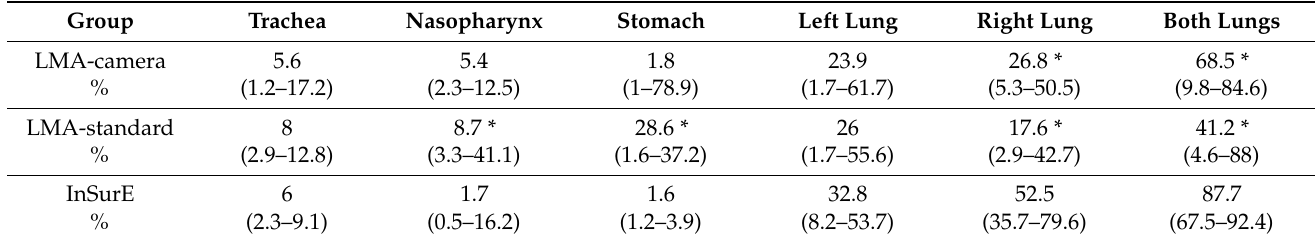
Table 2. Surfactant distribution as a percentage of the total administered